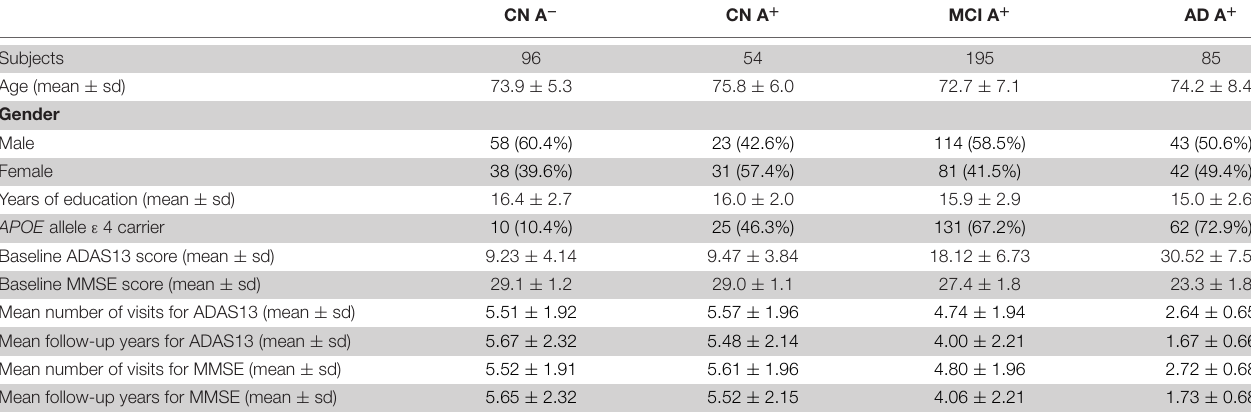
TABLE 1 | Clinical features of CN group with amyloid-negative, CN, MCI, and AD groups with